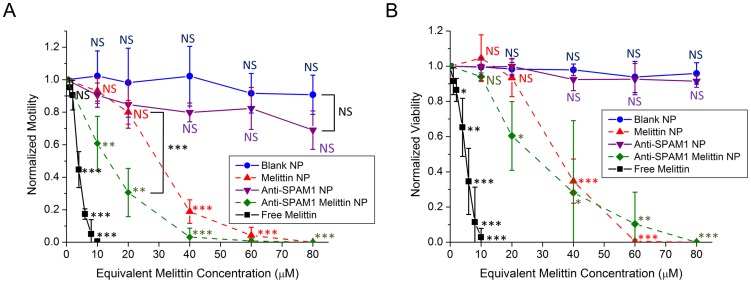
Effect of free melittin, blank NPs, mel-NPs, anti-SPAM1 NPs, and anti-SPAM1-mel-NPs on sperm motility and viability.(A and B) Sperm motility and viability following treatment with the appropriate agent for 30 minutes. Motility and viability were determined by IVOS Computer Assisted Sperm Analysis and normalized to the motility and viability of untreated sperm. Error bars represent S.D. of n = 3 replicates using sperm samples from distinct donors. Labels indicate level of statistical significance compared to untreated control, NS p>0.05, * p<0.05, ** p<0.01, *** p<0.001.